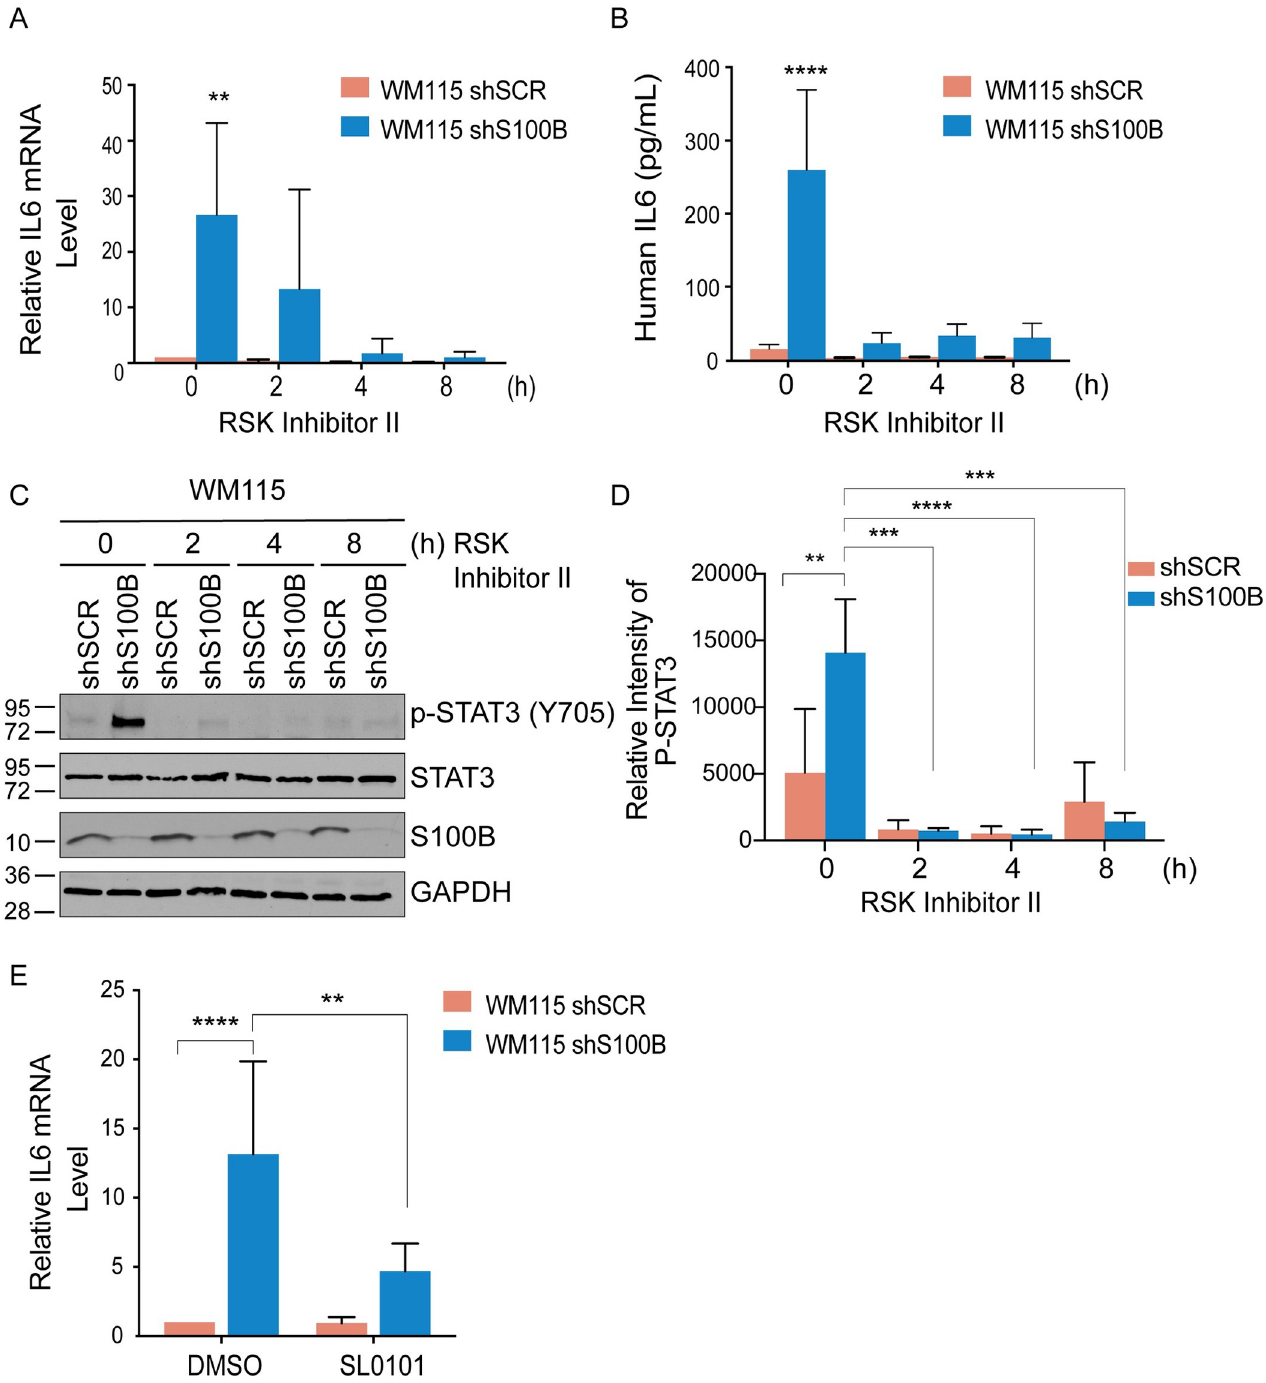
Fig 5. S100B regulation of IL6/p-STAT3 requires RSK. (A) qRT-PCR analysis of the IL6 mRNA and (B) ELISA of secreted IL6 protein in the media were performed on shSCR and shS100B WM115 cells after a 0, 2, 4, and 8 hours of treatment with RSK Inhibitor II, BI-D1870 (10 μ M). (n = 3, mean ± SD; �� , P < 0.005; ���� , P < 0.0001). (C) Immunoblot analysis of the p-STAT3 (Tyr705), total STAT3, and S100B in shSCR and shS100B WM115 cells following 0, 2, 4, and 8 hours of RSK Inhibitor II treatments (10 μ M) confirms that the RSK inhibitor prevents p-STAT3 (Tyr705). (D) The average values of relative p-STAT3 of three independent experiments were plotted using Image J (n = 3; mean ± SD; � , P < 0.05; �� , P < 0.005; ���� , P < 0.0001). (E) The inhibition of RSK with a second inhibitor (SL0101) also prevented the knockdown of S100B from restoring IL6 mRNA after 4 hours of inhibition with 10 μ M of SL0101 as was found with the other RSK inhibitor, BI-D1870. (n = 6; mean ± SD; �� , P < 0.005; ���� , P < 0.0001).